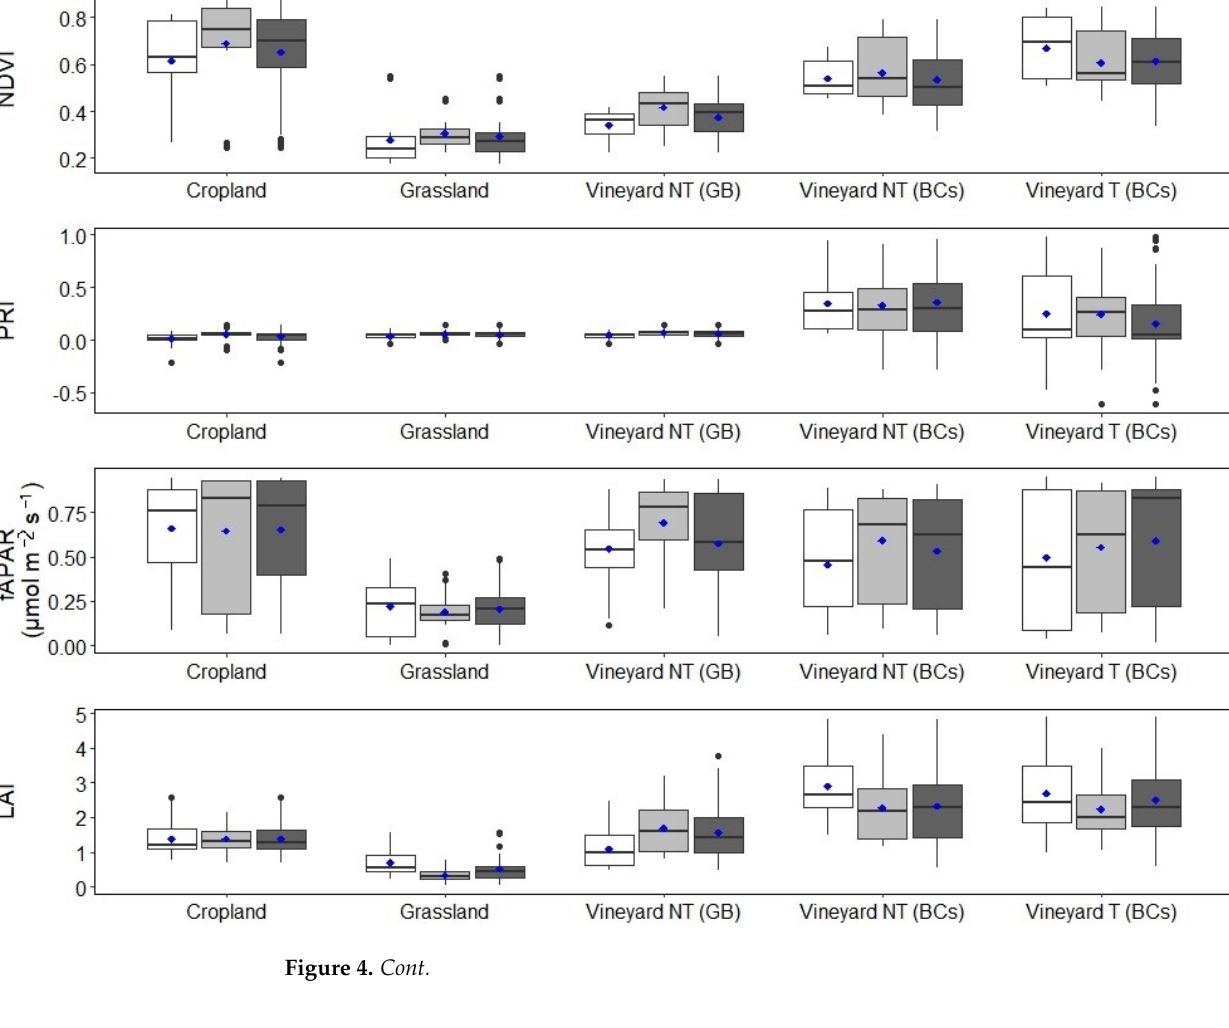
Figure 4. Boxplot of the upper and lower slope points’ data along with land use averages of NDVI, PRI, fAPAR, LAI ( n = 35), SWC ( v / v ), and soil temperature (°C; n = 70). Data showing yearly median (solid black line), mean (blue diamond), upper and lower quartiles, and minimum and maximum values (whiskers; data plus/minus 1.5 interquartile range).